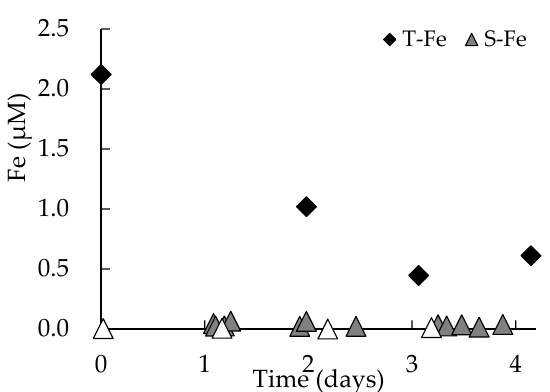
Figure 4. Total and soluble iron removal during storage. Open triangle: below detection limit.